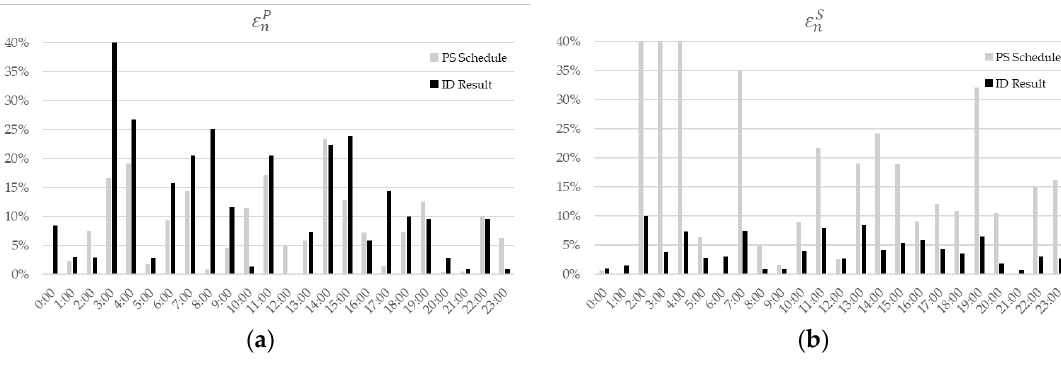
Figure 12. ( a ) 𝜀 𝑛𝑃 ( b ) 𝜀 𝑛𝑆 comparing between generation with PS schedule and result of ID operation Figure 12. ( a ) ε P n ( b ) ε S n comparing between generation with PS schedule and result of ID operation method. Table 3. Revenue of PS schedule and ID operation.